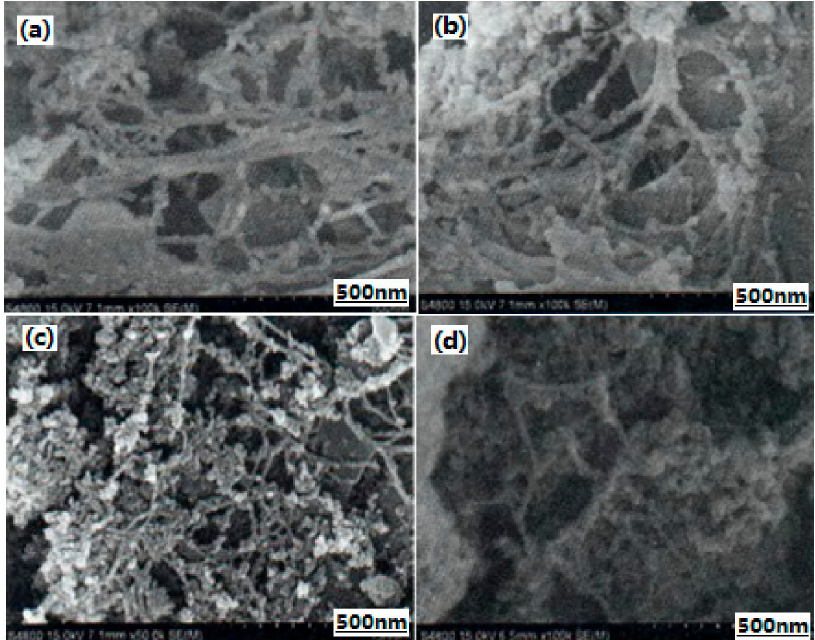
Figure 14. SEM photos of SiO 2 xerogel and nano-sized Al / RDX / SiO 2 composite particles. ( a ) SiO 2 xerogel; ( b ) 30%; ( c ) 50%; ( d ) 70%. Reproduced from [53], with permission from Han Neng Cai Liao,